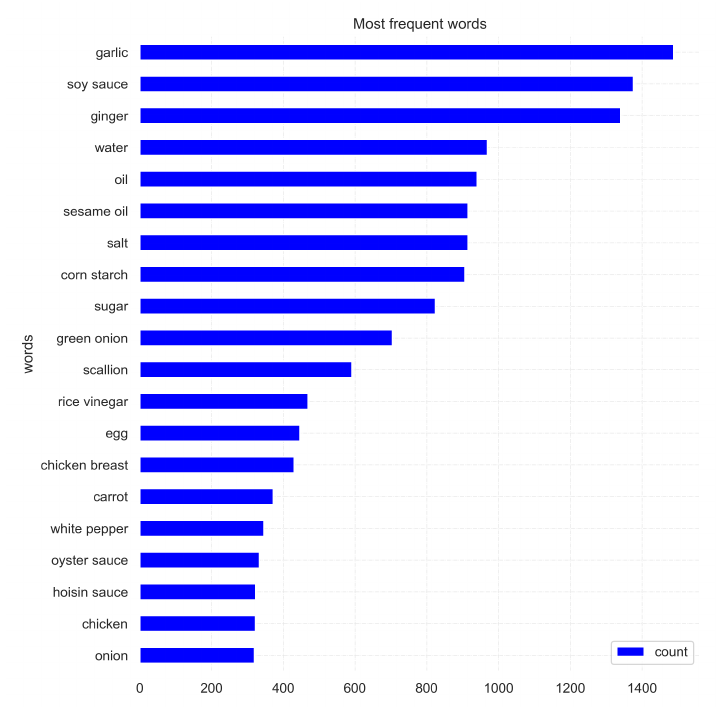
Figure 3. Top 20 ingredients for the Chinese cuisine